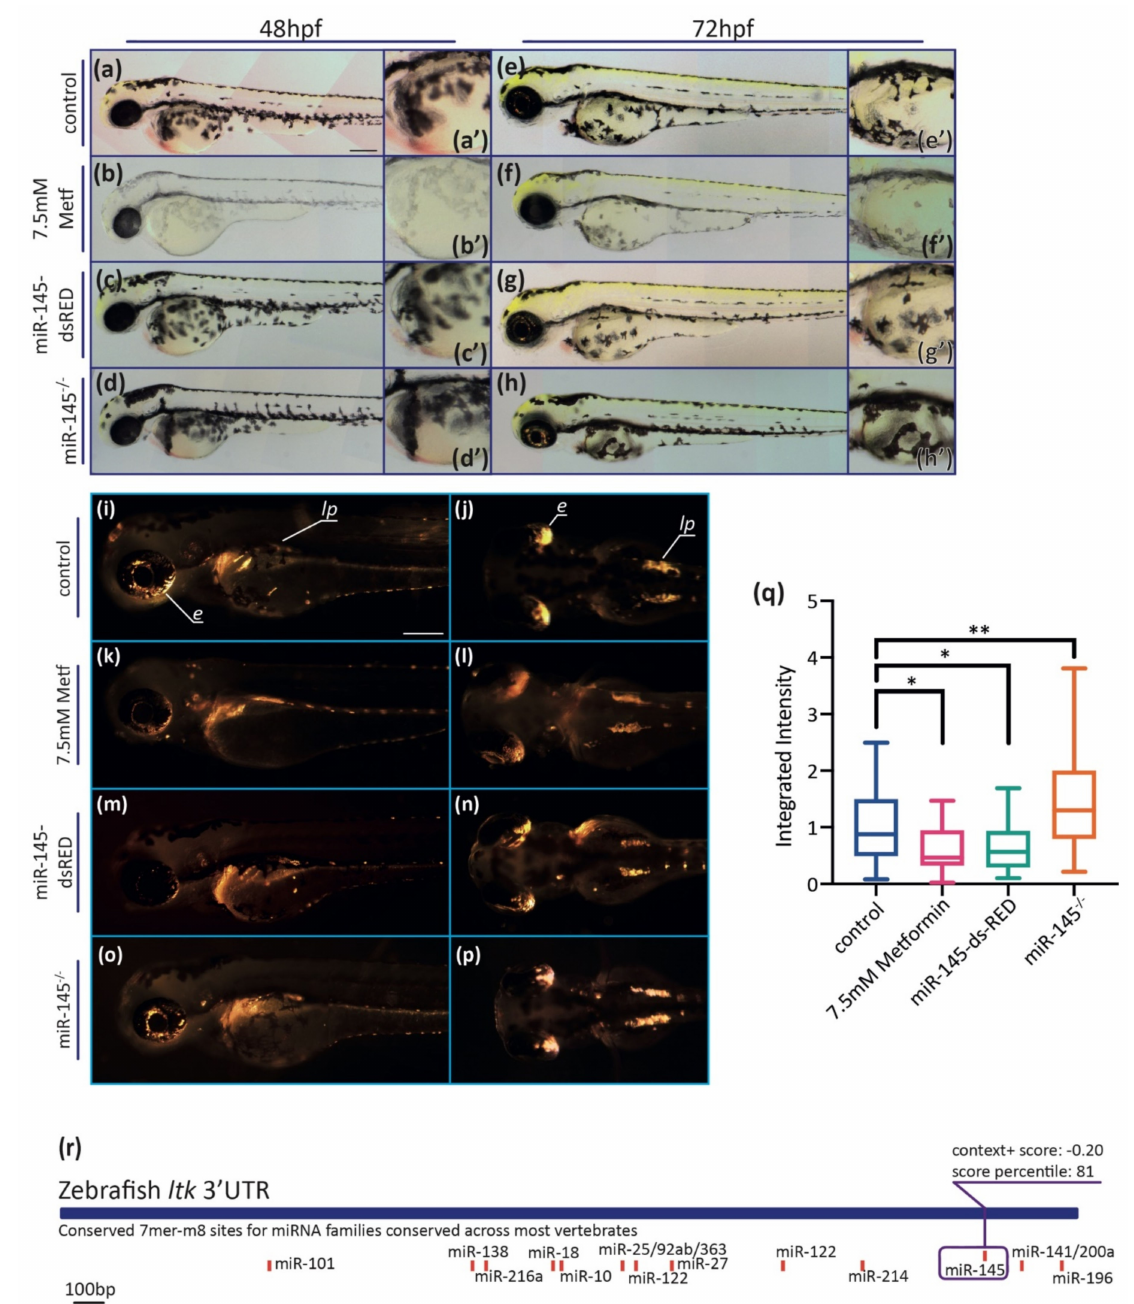
Figure 4. MiR-145 gain- and loss-of-function larvae display pigment developmental phenotypes. ( a – h ) Representative images of live metformin-treated ( b , f ) or miR-145-dsRED microinjected ( c , g ), and miR-145 − / − mutant ( d , h ) larvae and control siblings ( a , e ). Lateral views with head to the left, dorsal uppermost, of 48 hpf ( a – d ) and 72 hpf ( e – h ) specimens. Insets show enlarged regions of the yolk sac ( a (cid:48) – h (cid:48) ) in order to compare melanocyte differentiation phenotype. Scale bar represents 200 µ m in A for a-h. ( i – p ) Incident light images of 3 dpf larvae showing eye and trunk iridophores (silver spots) in wild-type sibling ( i , j ), and metformin-treated ( k , l ), miR-145-dsRED microinjected ( m , n ), and miR-145 − / − mutant ( o , p ) larvae. Pictures in ( i , k , m , o ) are lateral views while pictures in ( j , l , n , p ) are dorsal views, head to the left. Scale bar represents 200 µ m in ( i ) for ( i – p ). ( q ) Quantification of iridescent light of miR-145-dsRED microinjected, metformin-treated, and miR-145 − / − mutant larvae with their corresponding controls at 3 dpf. e : eyes; lp : lateral patches. ( ± SEM, n = 3, two-tailed Student’s t -test, * p < 0.05; ** p < 0.01). ( r ): Schematic representation of ltk (ENSDARG00000042681) 3 (cid:48) UTR. Putative miRNA binding sites are shown below each region. MiR-145 site is enclosed in a purple box, with its respective context+